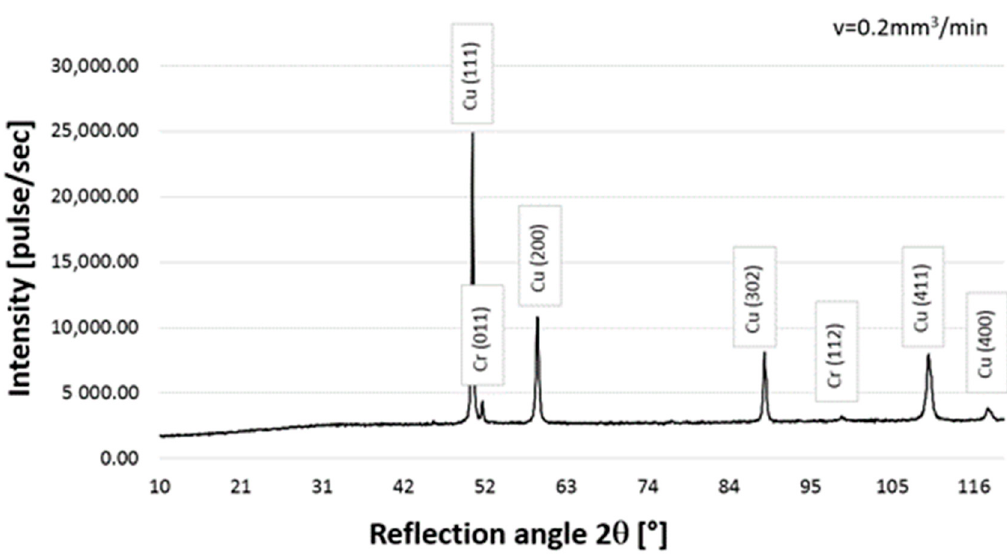
Figure 11. X-ray di ff raction pa tt ern for the qualitative CrAl coating on copper Cu-ETP, powder feed Figure 11. X-ray diffraction pattern for the qualitative CrAl coating on copper Cu-ETP, powder feed rate 0.4 mm 3 / min. rate 0.4 mm 3 /min.